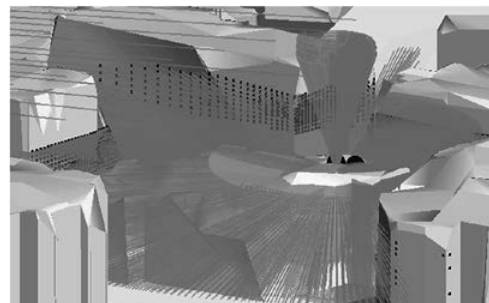
Fig. 6. Intersection points of rays and building facades